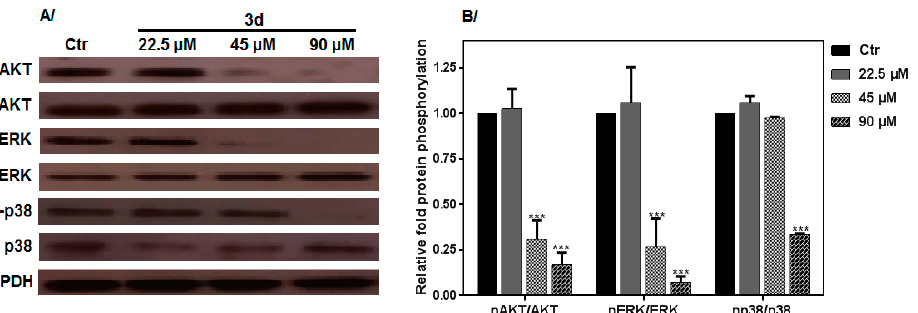
Figure 7. Western blot analysis: ( A ) K562 cells were treated with compound 3d for 1 h to evaluate the MAPK phosphorylation AKT, ERK1/2 and p-38; ( B ) relative protein phosphorylation/expression level. GAPDH was used as the internal standard; p < 0.05 was used to compare to the control group. All data were statistically significant ( p < 0.05) compared to the control (untreated cells). *** denote p < 0.001.